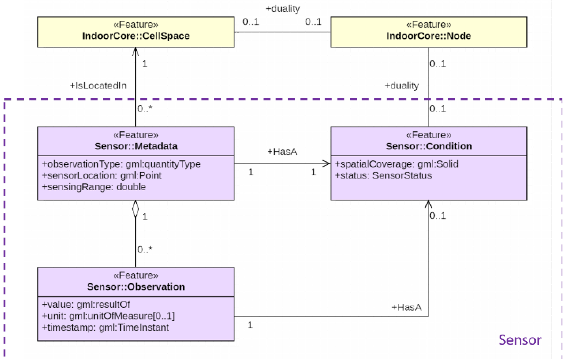
Figure 5. UML schema of proposed Sensor extension module for